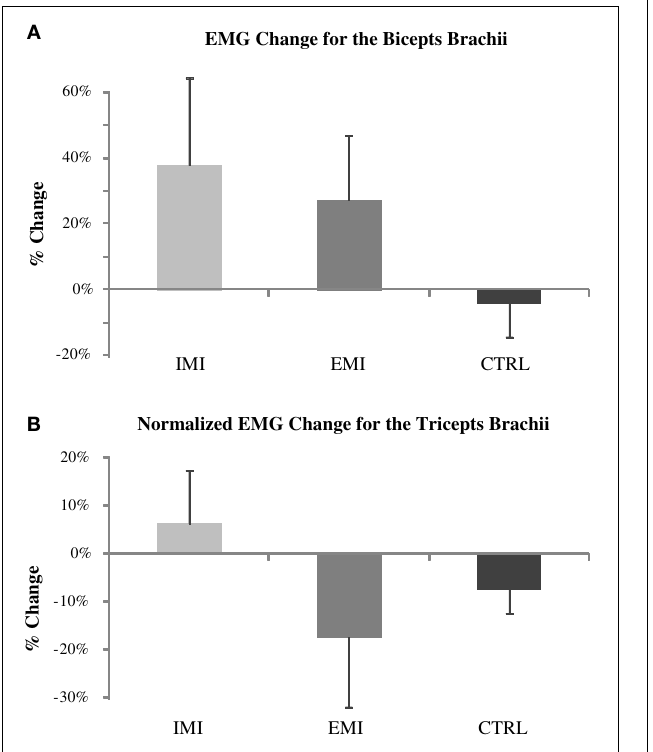
FIGURE 2 | Pre- to post-training percentage change in the biceps brachii (BB) average EMG (A) and normalized triceps brachii (TB) EMG (B) for IMI, EMI, and CTRL groups. The TB EMG during elbow flexion MVC was normalized to TB EMG during elbow extension MVC. The apparent BB EMG increases for the IMI and EMI training (upper panel) were not significant due to large data variations.